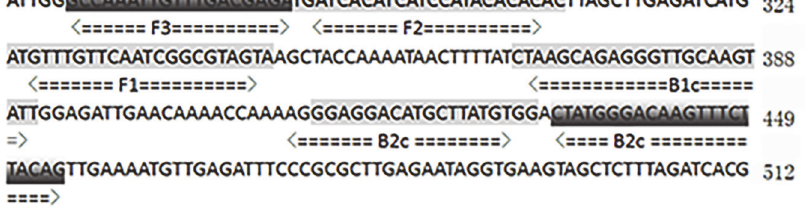
DNA. One microliter of the Fluorescent Detection Reagent (FDR) was added to each LAMP assay before the reaction, which allows the amplification reaction to be visually detected using an ultraviolet (UV) lamp or the naked eye. The reaction mixtures were set up in tubes and in- cubated in a Realtime Turbidimeter LA320C (Teramecs, Tokyo, Japan) at 65°C for 60 min, fol- lowed by 80°C for 5 min to terminate the reaction. The positive samples were distinguished from the negative samples by a turbidity cutoff value of (cid:1) 0.1 or by a color switch from the original orange to green. After amplification, the LAMP products were detected by electropho- resis on 2% agarose gels with ethidium bromide staining.